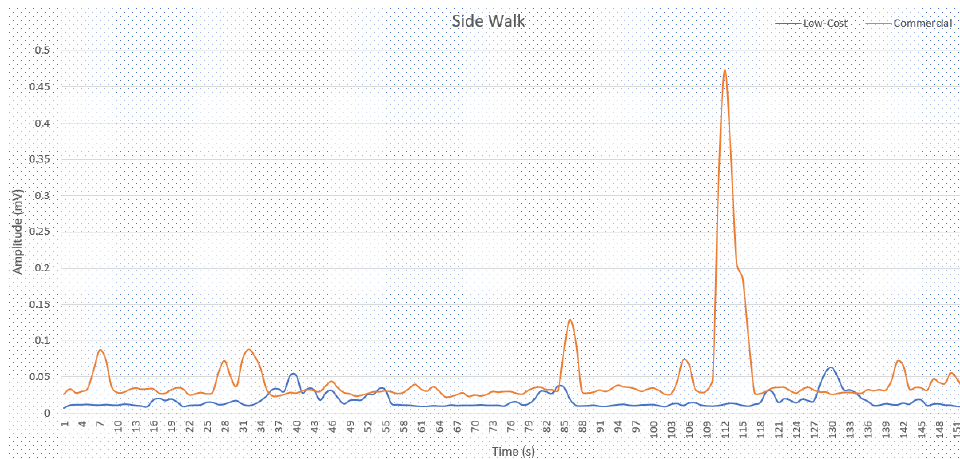
Figure 8. Amplitude graph of sidewalk. Synchronization of the two systems in Figure 9 for wall sit and Figure 10 for squat.